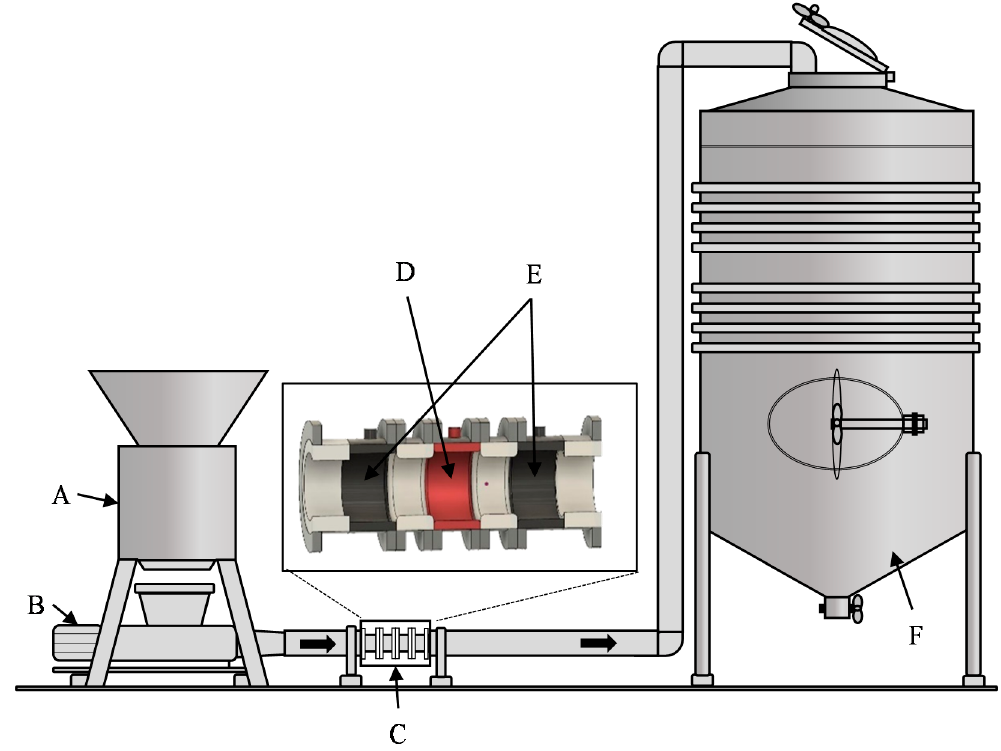
Figure 1. Flow chart of grape processing with PEF technology. ( A) destemming; ( B ) progressive cavity pump; ( C ) co-linear treatment chamber; ( D ) high voltage electrode; ( E ) ground electrode; ( F ) fermentation tank.